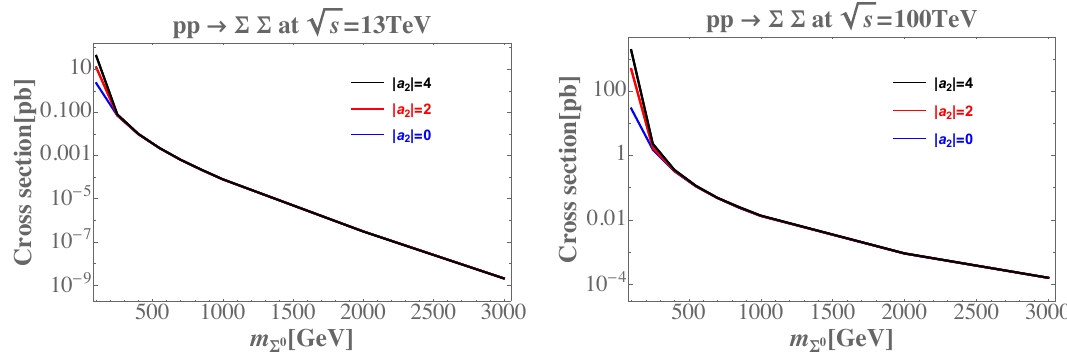
Figure 3 . Pair production cross sections of triplet particles Σ = Σ colliders as a function of m Σ 0 with representative values of a 2